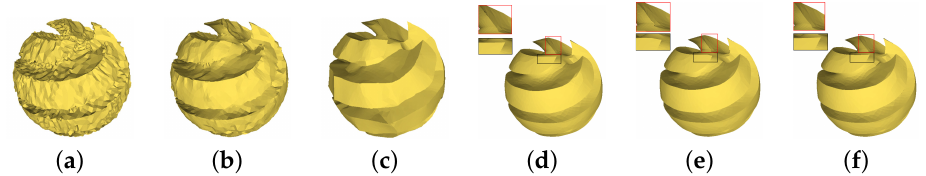
Figure 8. Comparison of the denoising effects of the updated feature points using different facet normals: ( a ) the noisy mesh; ( b ) update feature points using the current facet normals; ( c ) update feature points using the guidance normals; ( d ) update feature points using the last filtered facet normals in Equation (7); ( e ) update feature points using a approximate faltered normal n (cid:48)(cid:48) Equation (14), where n (cid:48) is replaced by the guidance normal g i ; ( f ) our f i